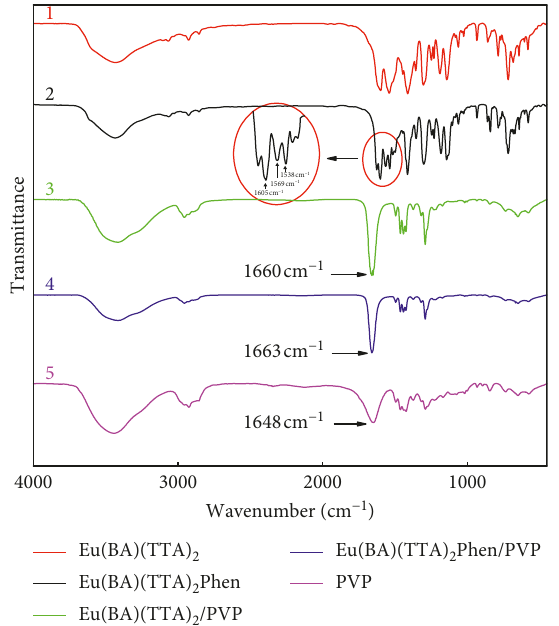
Figure 2: FT-IR spectra of Eu(BA)(TTA) 2 (curve 1), Eu(BA)(T- TA) 2 Phen (curve 2), Eu(BA)(TTA) 2 /PVP (curve 3), Eu(BA)(T- TA) 2 Phen/PVP (curve 4), and PVP (curve 5),